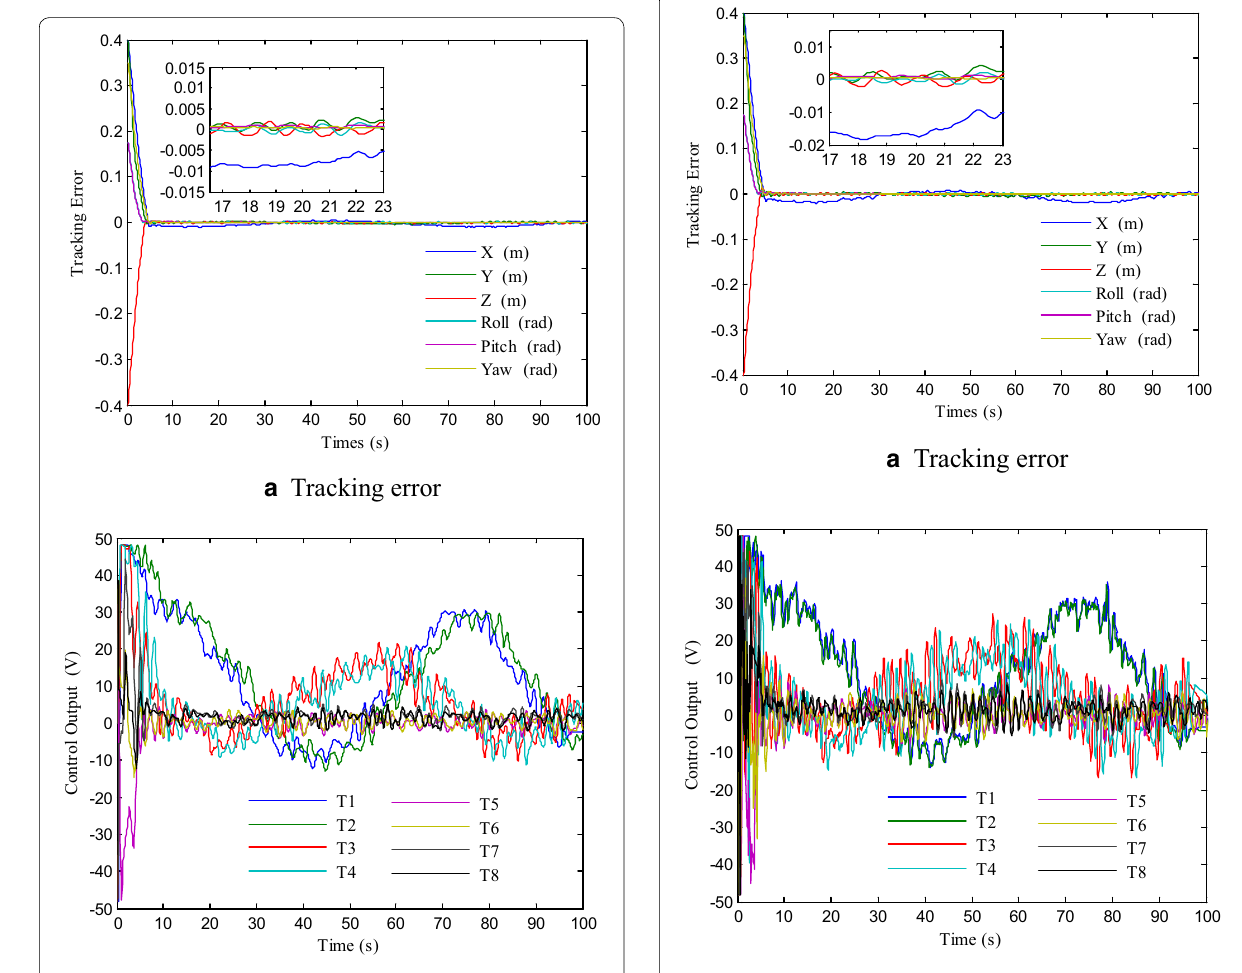
b Control voltage for AUV thruster Figure 7 Chattering‑reduction effect of the Ref.